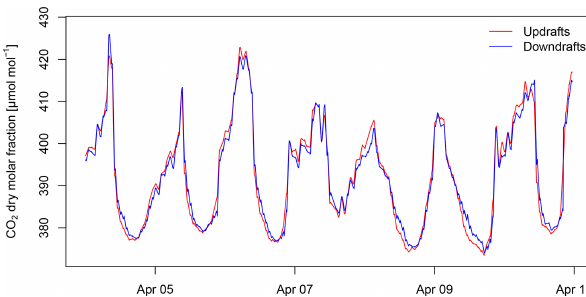
Figure 12. Difference in dry mole fractions of CO 2 between the updraft and downdraft reservoirs of the true eddy accumulation de- vice. The 30min raw time series shown is the result of subtracting the mole fraction in the downdraft reservoir from the mole fraction in the updraft reservoir (Fig. 11). A positive CO 2 mole fraction dif- ference indicates a CO 2 flux away from the surface (respiration), and a negative CO 2 mole fraction difference indicates a CO 2 flux towards the surface (assimilation).